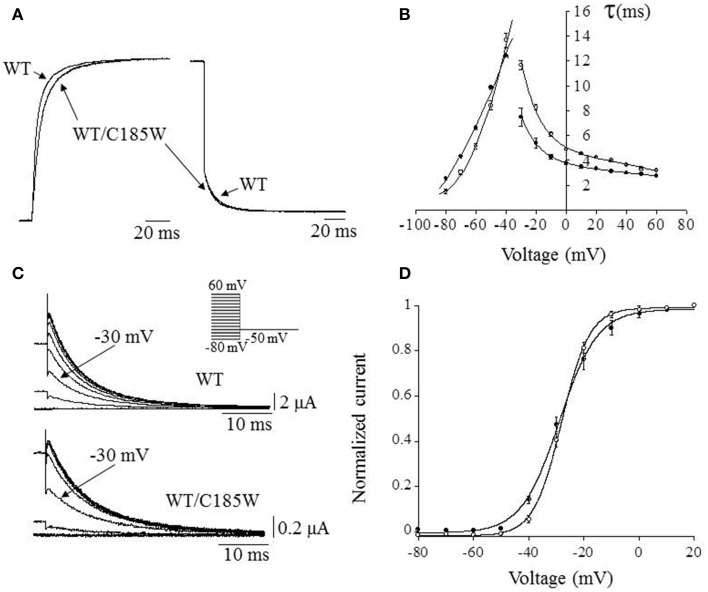
Effects of the mutation on activation/deactivation kinetics and voltage-dependence of heteromeric channels. (A) Representative current trace recorded at +60 mV for WT channels, overlain with that resulting from the co-injection of WT + C185W cRNAs (1:1). (B) The activating and deactivating current traces were fitted with a double and single exponential function, respectively, in order to assess the effects of the C185W mutation on the activation and deactivation kinetics of the channel. The relevant time constants for the WT (•), WT/C185W (°; 1:1 ratio) channels were calculated and plotted as a function of the test pulse in (B). This plot shows that the mutation affects channel activation (τfast) which can be directly observed also from (A). (C) Sample tail current families for the indicated channels recorded at −50 mV, after 200 ms pre-pulse commands from −80 mV to 60 mV (HP = −80 mV; ΔVincrement = 10 mV, inset). Note that although tail currents for WT/C185W channels are significantly smaller than the WT (see calibration bars) the relative current amplitudes, after a pre-pulse potential to −30 mV (arrows) are similar, denoting that both channel types have analogous V1/2 values. (D) The voltage-dependence of channel activation was determined by normalizing tail current-voltage data points for WT (•) or WT/C185W (°; 1:1 ratio) and by calculating the V1/2 and slope factor k from fits with the Boltzmann function I = 1/1 + exp{–(V – V1/2)/k} (solid curves). Notice that the mutation increases the steepness of the voltage-dependence of heterozygous channels.